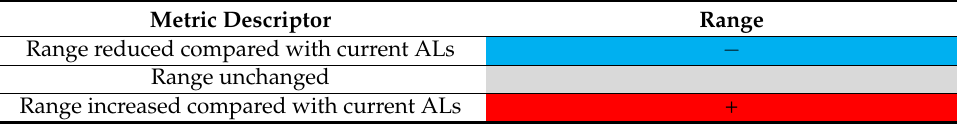
Table 4. Metrics used to help interpret scenario comparisons—range of